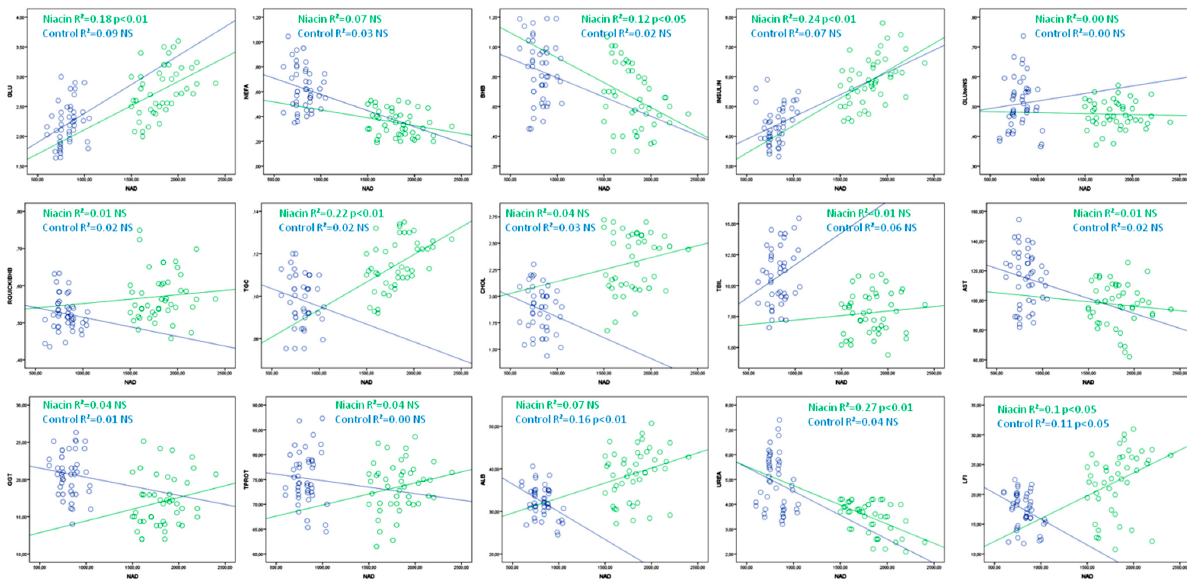
Figure 3. Linear regression line between NAD and metabolic parameters in cows receiving (green) and not receiving niacin